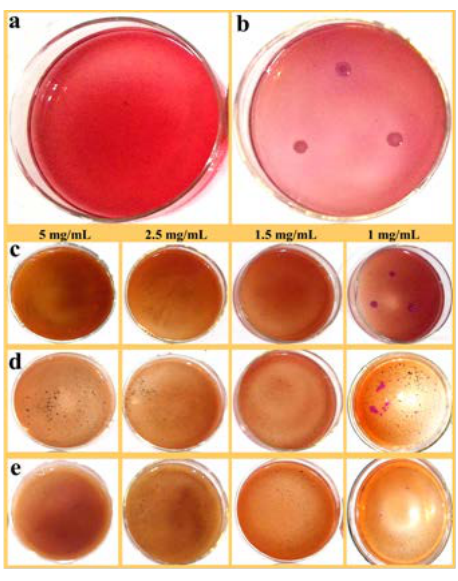
Figure 6. ( a ) Blank control, ( b ) positive control of E. coli and E. coli treated using ( c ) ZnO / PAL, ( d ) ZnO / PAL-1 and ( e ) ZnO / PAL-2.